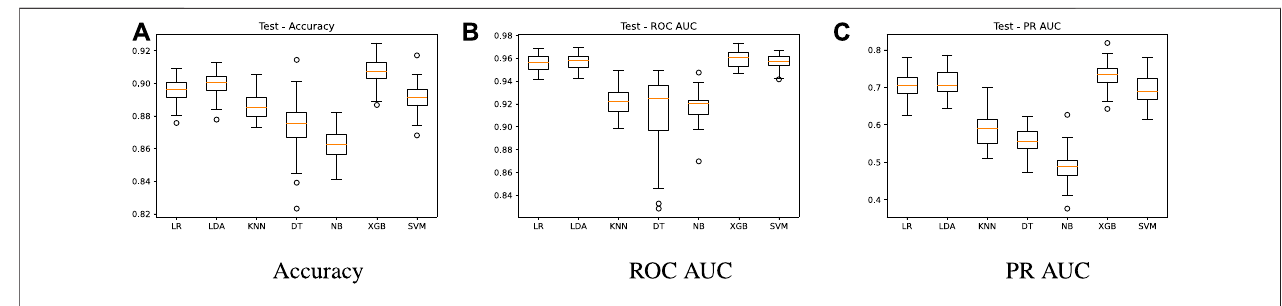
FIGURE 4 | Test results - algorithms comparison.